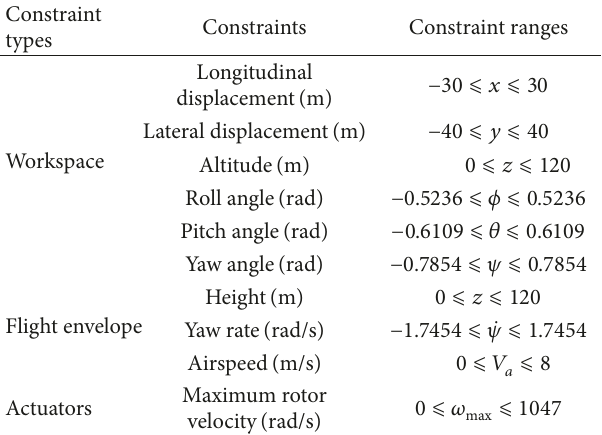
Table 3: Considered constraints.